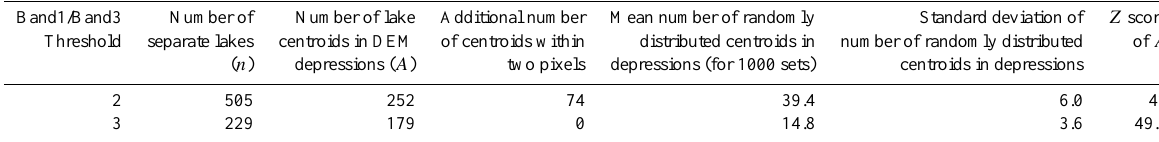
Table 1. Co-location statistics for observed lakes and DEM